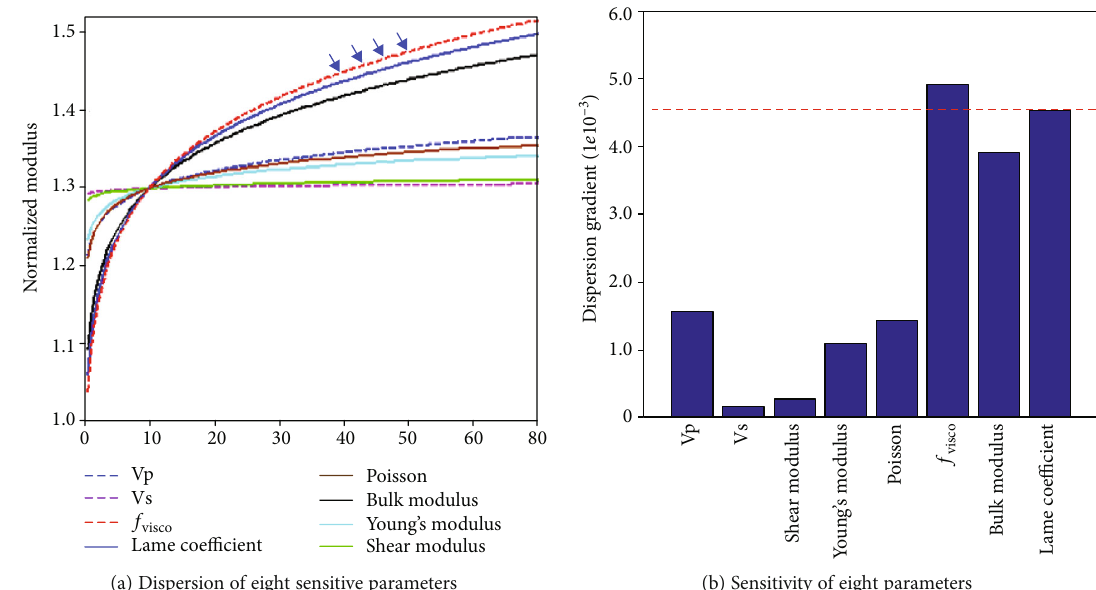
Figure 1: Sensitivity degree model